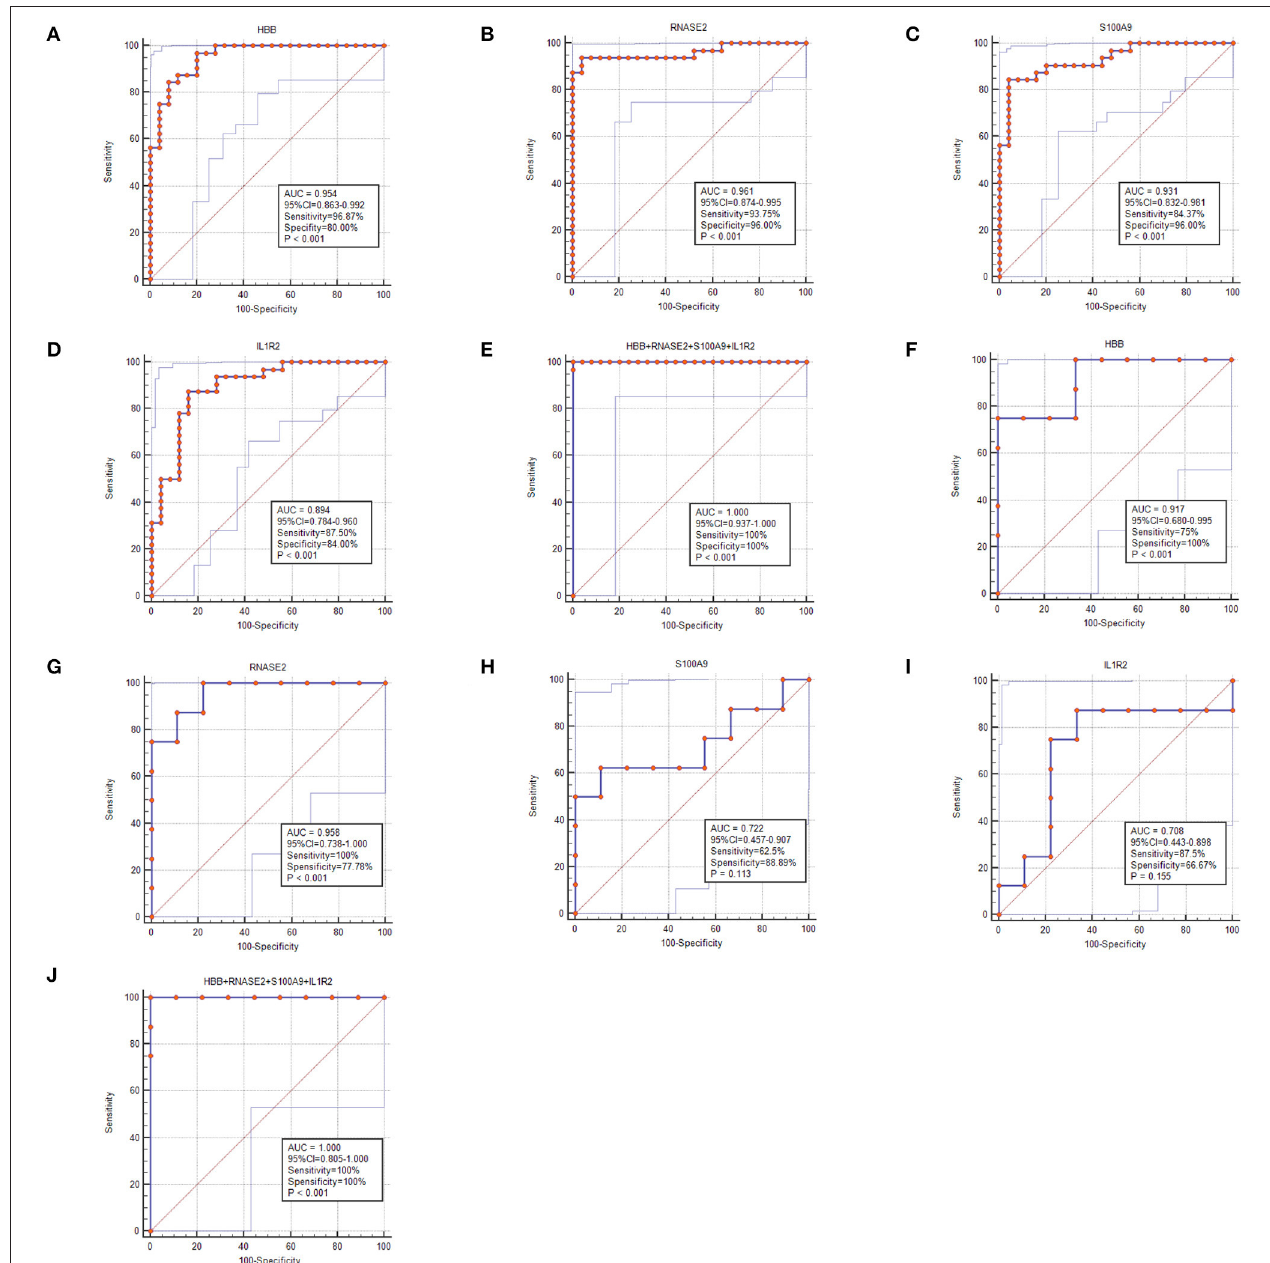
FIGURE 5 | The receiver operating characteristic (ROC) curve of the diagnostic effectiveness of the feature genes. (A–E) ROC curve of HBB, RNASE2, S100A9, IL1R2 , and support vector machine (SVM) classifier in GSE117261; (F–J) ROC curve of HBB, RNASE2, S100A9, IL1R2 , and SVM classifier in GSE48149.